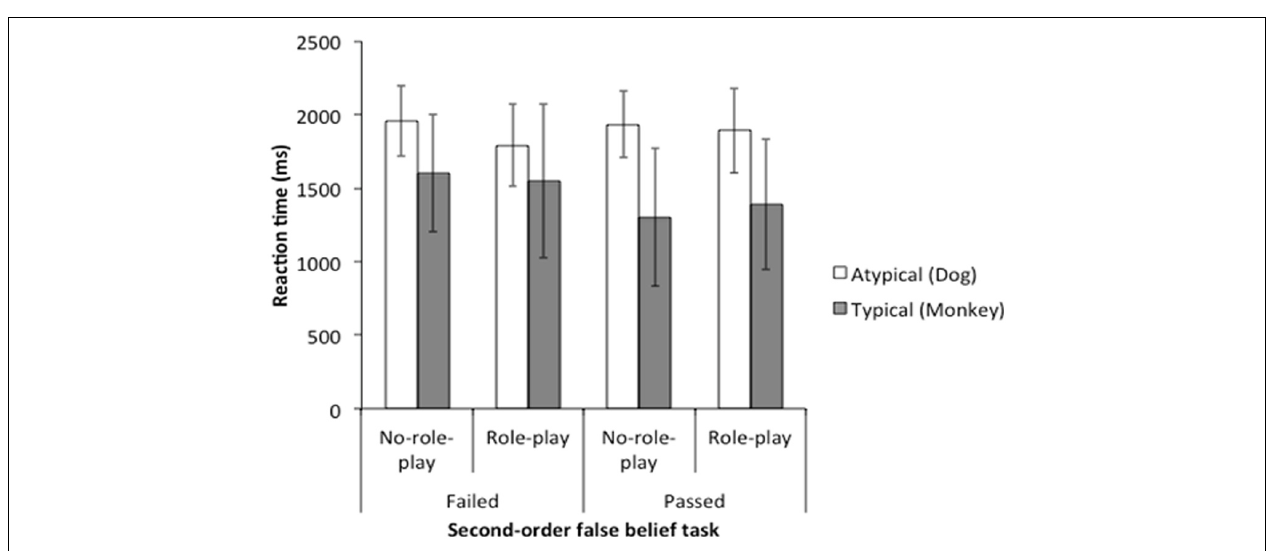
FIGURE 3 | Means (and Standard Deviations) of accuracy rates.